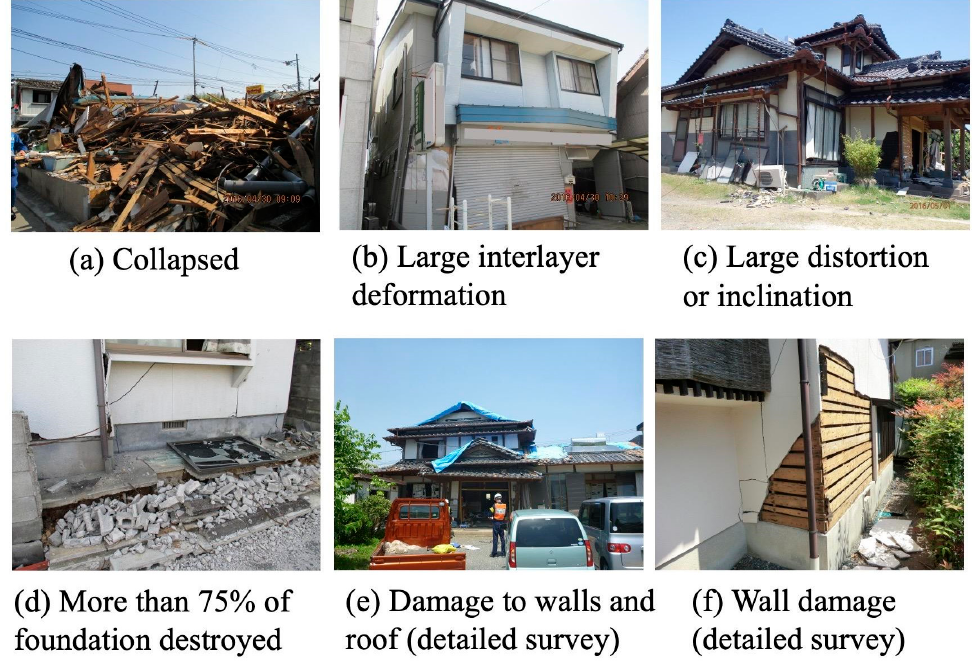
Figure 3. Photographs of the buildings classified as Major damage. Table 1. Characteristics of each damage class and the number of buildings.